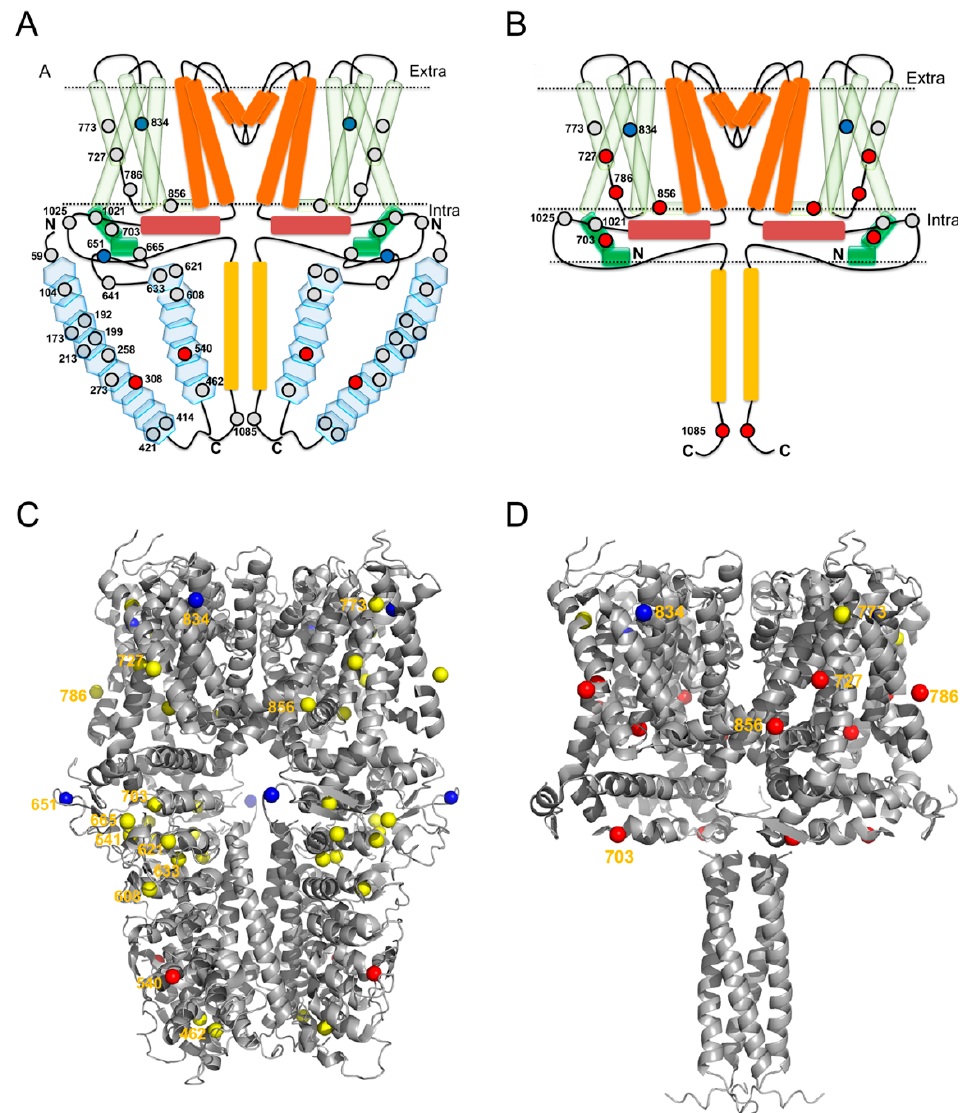
Figure 6. Structural localization of human TRPA1 (hTRPA1) cysteines and their reactivity to N-methylmaleimide (NMM). ( A , B ) Schematic representation of structural elements in hTRPA1 and position of cysteine residues. The subunits in the hTRPA1 are arranged into a tetramer surrounding a common ion permeation pathway. For clarity, only two subunits of the tetramer are displayed. ( A ) Each subunit of hTRPA1 contains 28 cysteines highlighted by circles. The red and blue circles are representing an increase and a decrease in NMM labeling of the cysteines, respectively, in response to increased concentrations of NMM. ( B ) The N-terminal ARD deleted version of hTRPA1 ( Δ 1-688 hTRPA1) has only 9 cysteines per monomer and a deviating pattern of NMM labeling. The domain organization of TRPA1 is represented in different colors, from N-terminus to C-terminus; Ankyrin repeat domain—blue (transparent), pre-S1 region—green (transparent), S1-S4 α -helices—light green (transparent), S5-S6 and pore helices—orange, TRP like domain—brick red, coiled-coil domain—yellow. ( C , D ) Single particle cryo-EM structure of human TRPA1 (PDB ID: 6V9W). (C) Cartoon representation of hTRPA1 showing a side view of the resolved part of the tetrameric assembly with the transmembrane domain at the top. 14 of the 28 cysteines in the monomer are resolved in the structure and their sulphur atoms are shown as spheres. ( D ) The same representation but with the cytosolic N-terminal ARD completely removed displaying 6 of the 9 cysteines present in the truncated monomer of hTRPA1 ( Δ 1-688 hTRPA1). The red and blue colored spheres represent cysteines exhibiting an increase and decrease, respectively, in the NMM labeling at higher concentrations of NMM. For clarity, the labels of the different cysteine residues are only displayed once, and in the monomer where it is best visible.